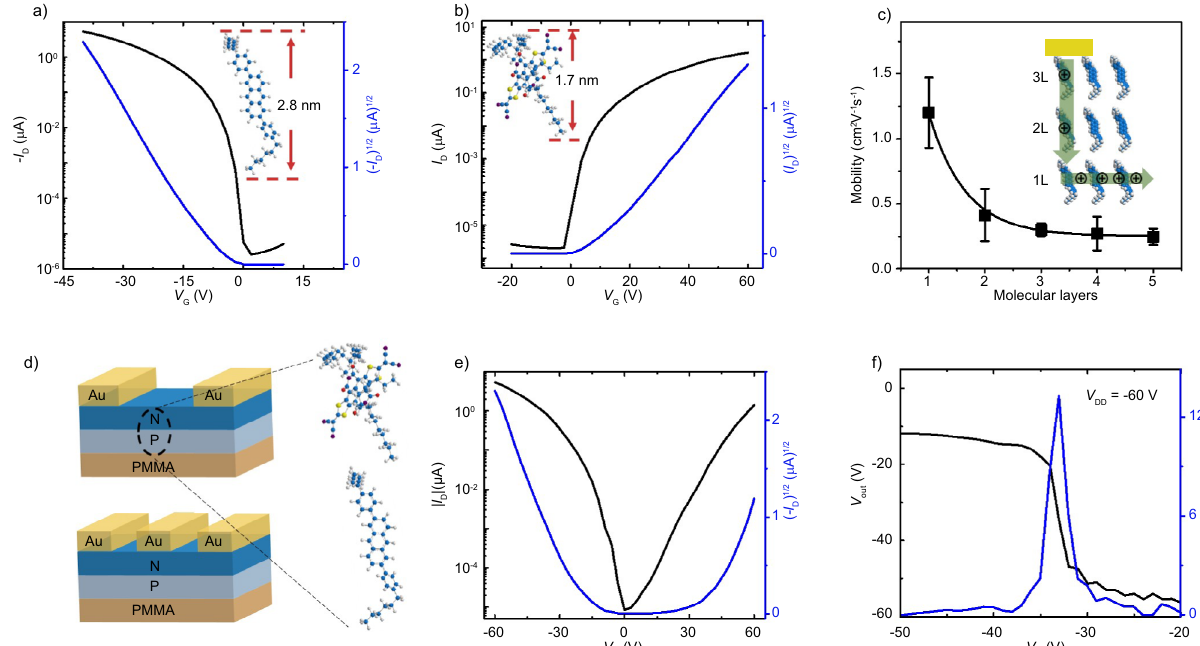
Fig. 3 Electrical performance of MMCs and bimolecular layer p – n heterojunction devices. a , b Transfer curves of p-type C 6 DPA and n-type NDI MMC devices. c Mobilities for C 6 DPA devices with different molecular layers (the insert is the working diagram of multilayer crystal device). d Schematic diagram of bipolar device and inverter device based on NDI (n type)-C 6 DPA (p type) heterojunctions. e Transfer curves of p – n heterojunctions devices. f Characteristics of the inverter at V DD = − 60 V.